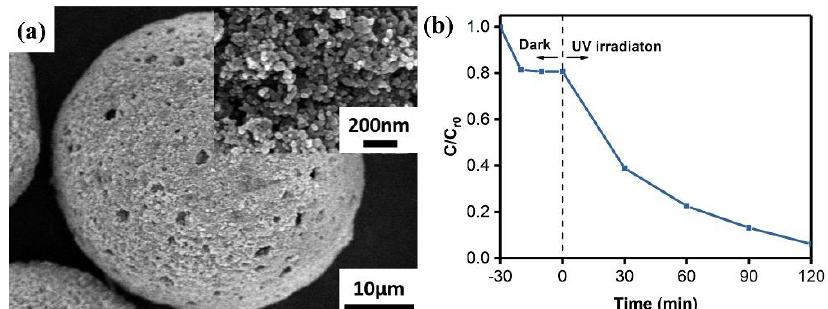
Figure 9. SEM image of ( a ) TiNPs/PSF-0.40 composite after soaking in 3N HCl for 1 h, ( b ) TiNPs/PSF-0.40 photodegradation of MB under PH = 1 condition, 30 min in dark and posterior 120min under UV irradiation.